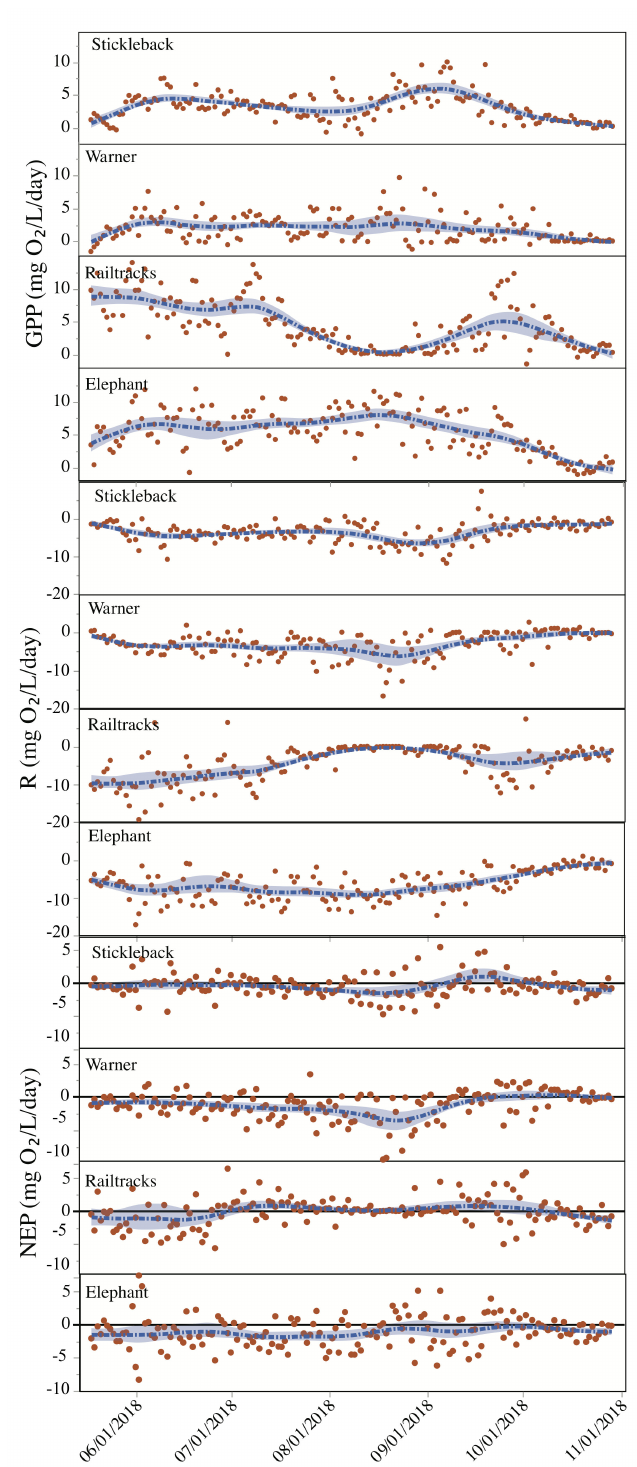
Figure 10. Seasonal variation in GPP, R and NEP for four ponds in east-central Minnesota, USA. Fitted curves are cubic splines with a λ of 0.5. The shaded areas are bootstrapped confidence